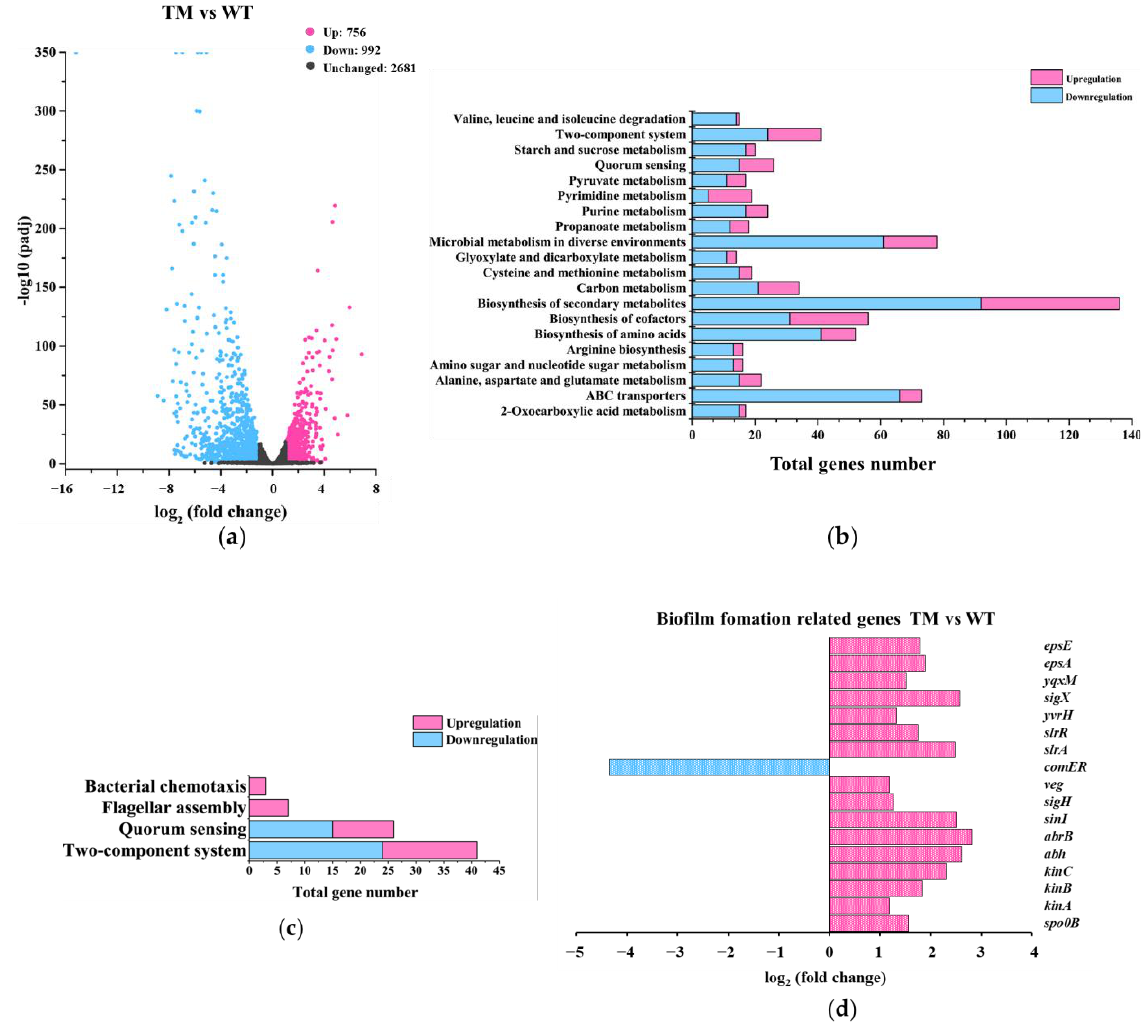
Figure 3. Analysis of the gene-expression differences between TM and WT. ( a ) A volcano plot showing the DEGs found in TM compared with WT. DEGs were defined as the genes whose expression was up-regulated (pink dots) or down-regulated (blue dots) with a fold change of two or more ( p ≤ 0.05), when TM was compared with WT. Black dots represent genes without a significant change in expression. ( b ) Profiling of the DEGs via using the annotation of KEGG. ( c ) Grouping the DEGs by the indicated metabolic pathways. ( d ) Changes in the expression of the known biofilm − formation genes found as